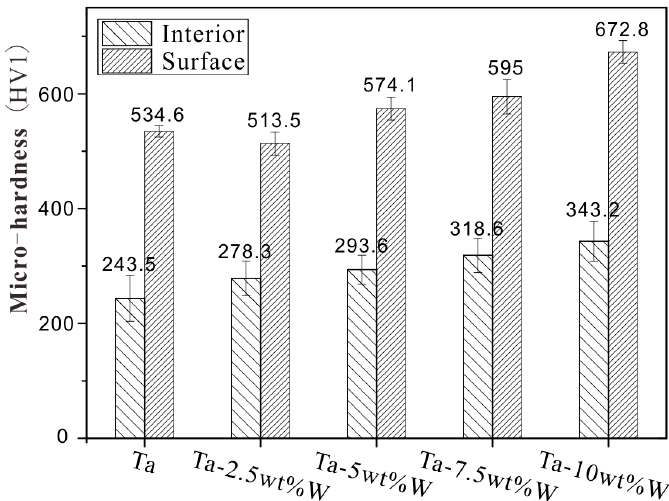
Figure 5. The superficial and internal micro-hardness of Ta-W alloy.